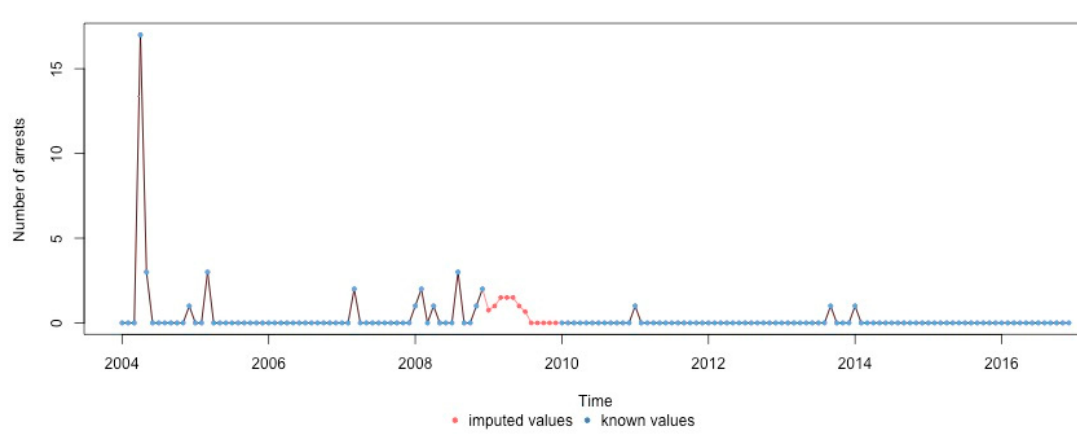
Figure A24. Heroin organized Vietnamese nationals crime arrests 2004–2016 in the Czech Republic – imputed missing values .